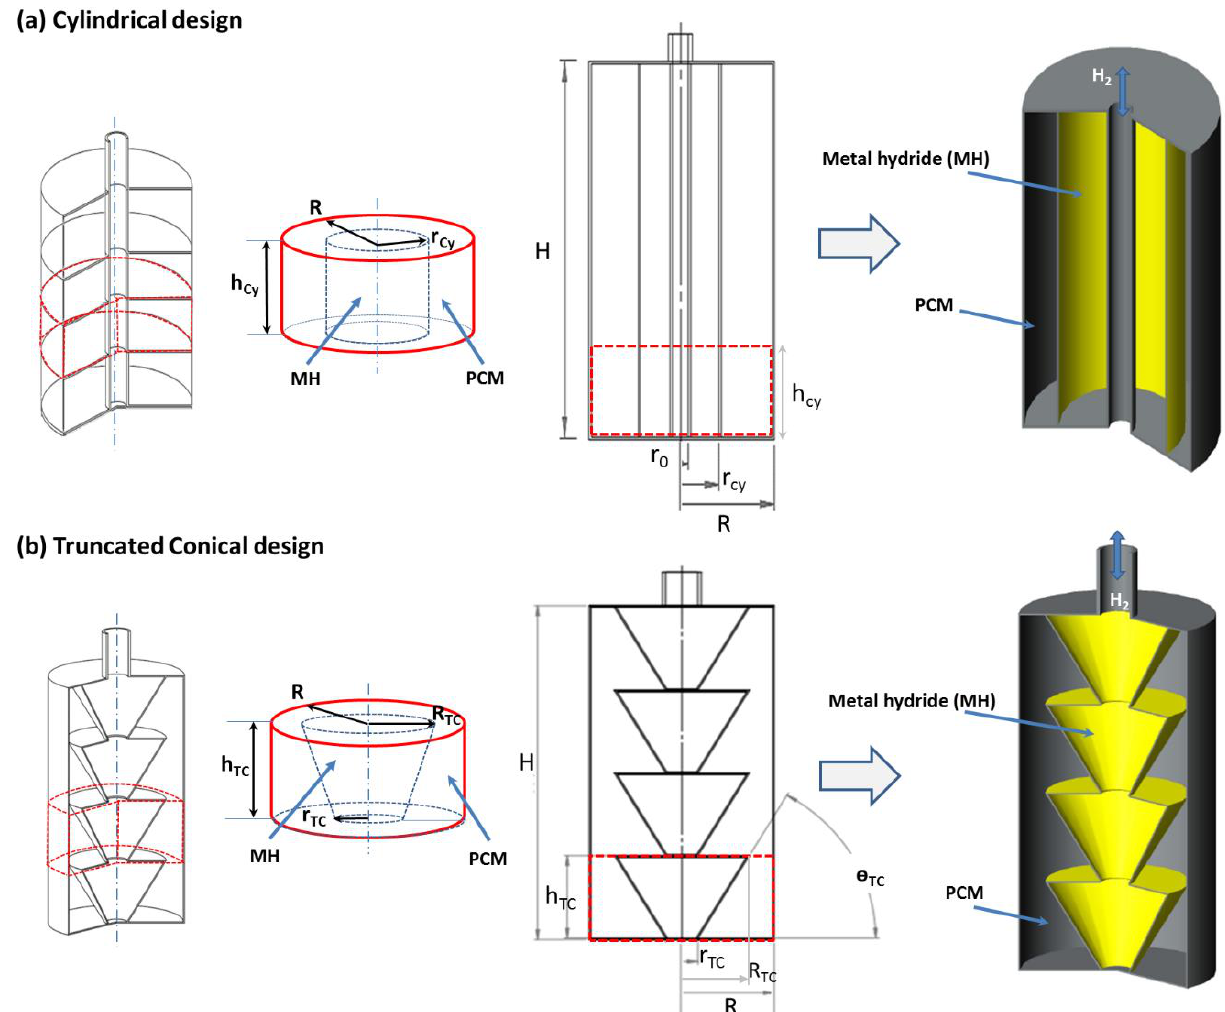
Figure 1. Two kinds of MH-PCM tanks integrated with a stack of compacted disks: ( a ) cylindrical MH bed and ( b ) truncated conical MH bed.